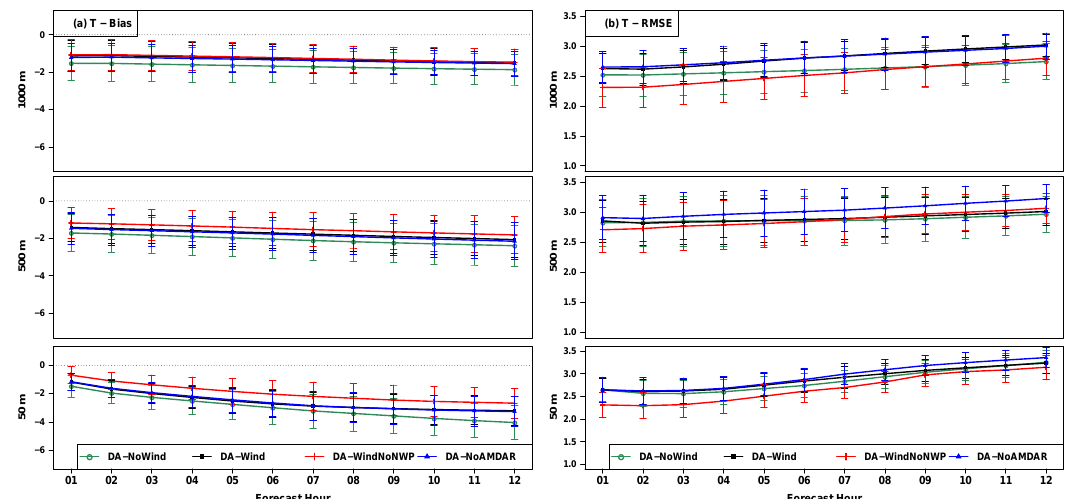
Figure 5. Time series of statistics as function of forecast hours (up to 12 h) for temperature at the following vertical levels: 50 m, 500 m and 1000 m: ( a ) Bias (left), and ( b ) RMSE (right). The error bars represent the confidence intervals at